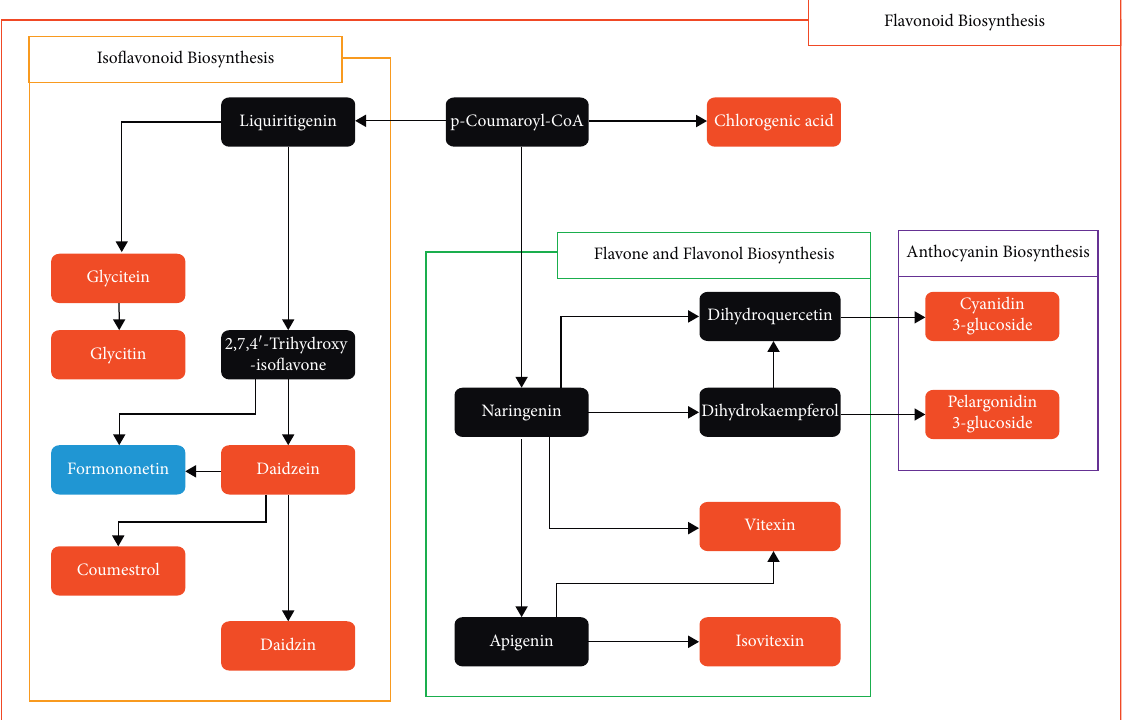
Figure 7: Biosynthesis pathway of secondary metabolites in the mungbean seed coat. Te compounds used as standards for UPLC are indicated in red and blue. Red boxes indicate the compounds detected, and blue boxes indicate the compounds not detected in both extracts of the whole sprout and seed coat. Black boxes indicate the precursors of the target compounds